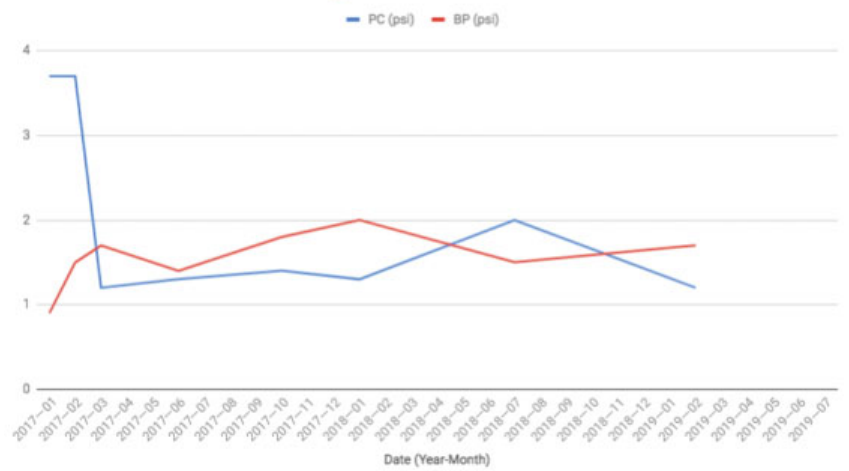
Fig. 3 Pressure of correction (PC) and bracing pressure (BP) over time. PC is how much pressure it takes to push the carinatum into a neutral position. BP is how much pressure the brace is applying to the chest during treatment. The BP dropped sharply. The initial PC was lower than that normally used, but was increased slowly since it appeared to be well